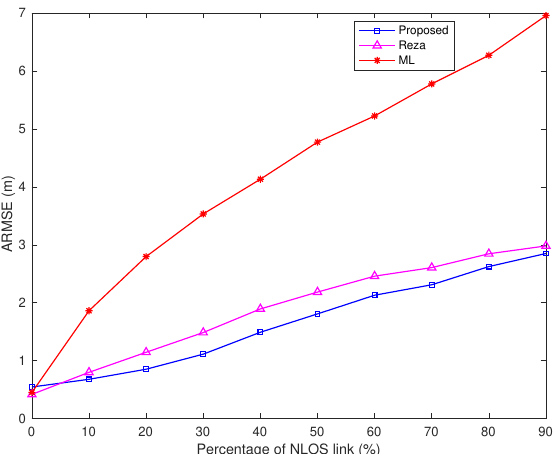
Figure 9. ARMSEs vs. percentage of NLOS links ( σ = 0.5 m, and the NLOS error bound B max is 10 m).